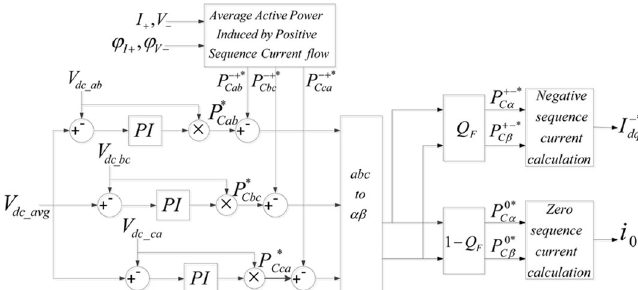
Fig. 4 Inter-cluster balancing control using quantification factor for sharing